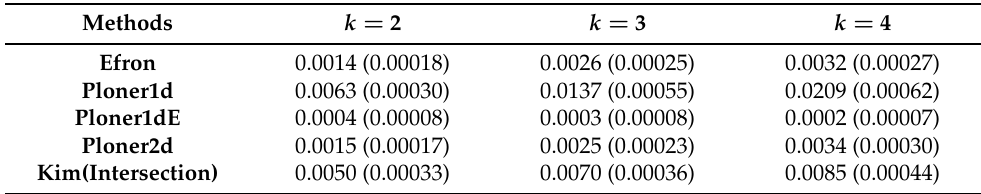
Table 5. Scale change scenario (two-sided alternative): means and standard errors of estimated FDRs over 100 repetitions (cutoff = 0.1).